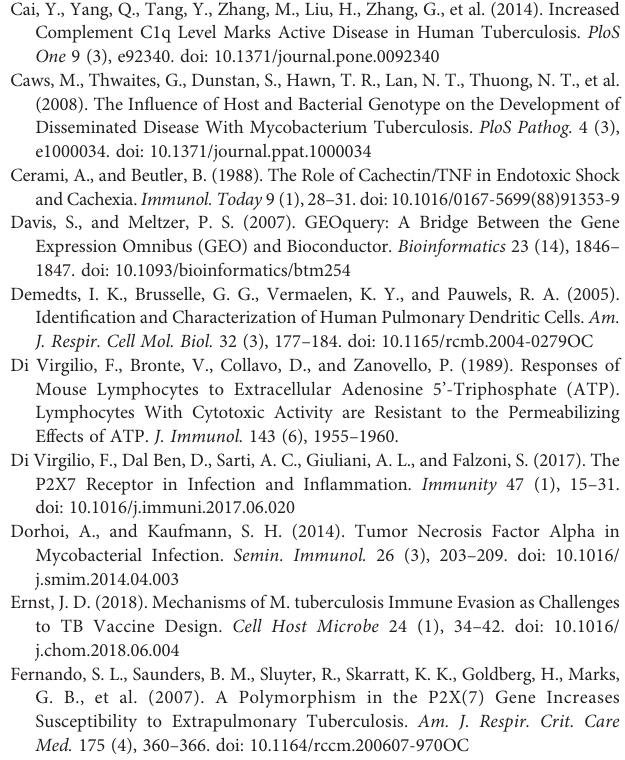
Supplementary Figure 1 | Gate strategies for the analyses of myeloid cells and CD4 + T cells are shown in mice infected with MP287/03 mycobacteria, treated or not treated with BBG. C57BL/6 mice were infected i.t. with ~100 MP287/03 bacilli. Lung cells were evaluated at day 28 of infection. (A) Gate strategies to evaluate CD45 + , CD45 + Lin - CD11b + , CD45 + Lin - CD11b + CD11c + , CD45 + Lin - CD11b + GR1 + cells are shown. (B) Gate strategies to evaluate CD4 + T cells and CD69 + CD44 + CD4 + T cells are shown. Supplementary Figure 2 | BBG treatment does not interfere with pulmonary immunological parameters in uninfected C57BL/6 mice. Four doses of BBG (45 mg/kg) were administered i.p. every two days in C57BL/6 mice, and lung cells were harvested 7 days after the fi rst dose. Untreated C57BL/6 mice were used as controls. (A) SchematicrepresentationoftheexperimentalBBGtreatmentprotocolis shown. (B) Lungweightsareshown. (C) Cellnumbersperlungareshown. (D) CD45 + , CD11b + CD45 + and CD11c + CD11b + CD45 + , GR1 + CD11b + CD45 + cellnumbers per lungareshown. (E) CD4 + andCD69 + CD44 + CD4 + Tcellnumbersperlungareshown. (F) Cytokine levelsin48h-culture supernatants oflung cellsareshown.No signi fi cant difference was observed using Mann-Whitney non-parametric T